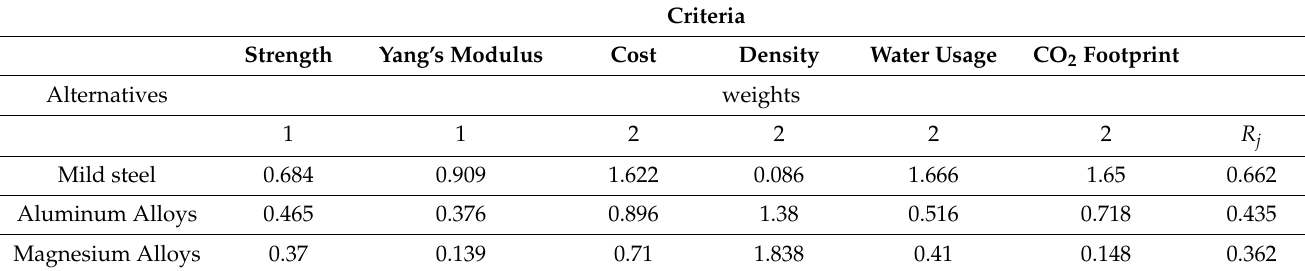
Table 4. Ranking decision score when the CO 2 footprint, cost, density and water usage are prioritized twice as much as others.